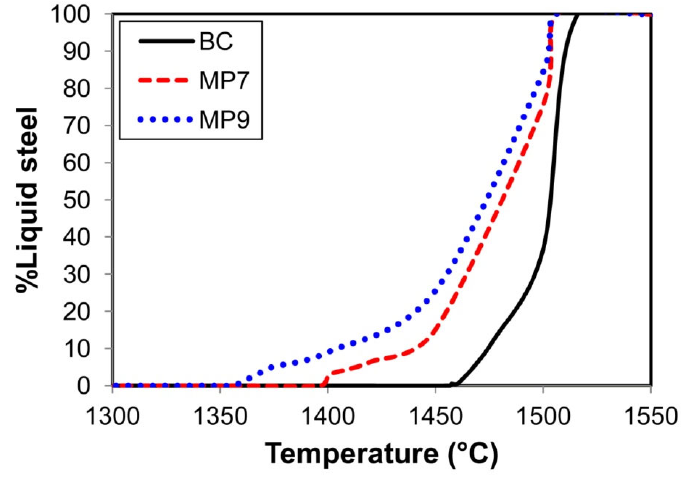
Figure 3. Solidification curves for MP9, MP7 and BC weld metal compositions from Table 3.